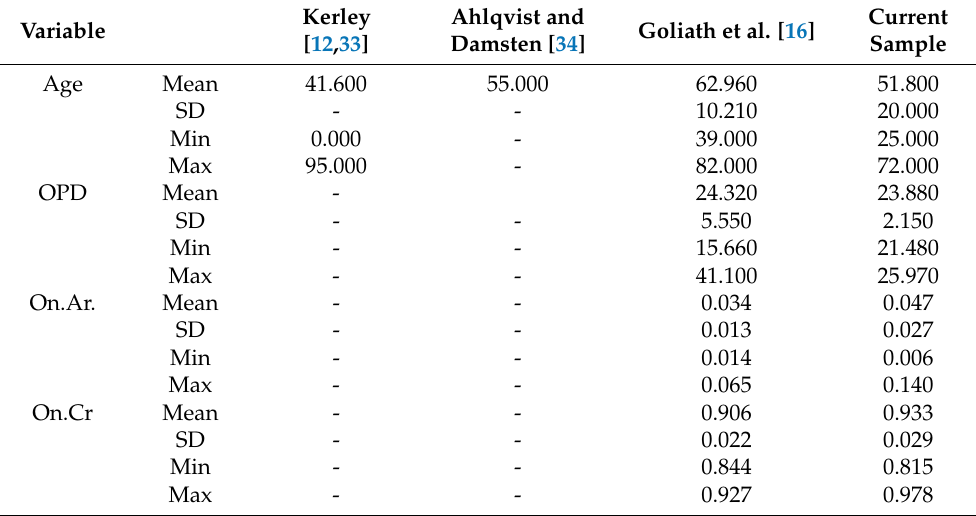
Table 8. Descriptive statistics for the age and the histomorphometric variables of the current and reference femur